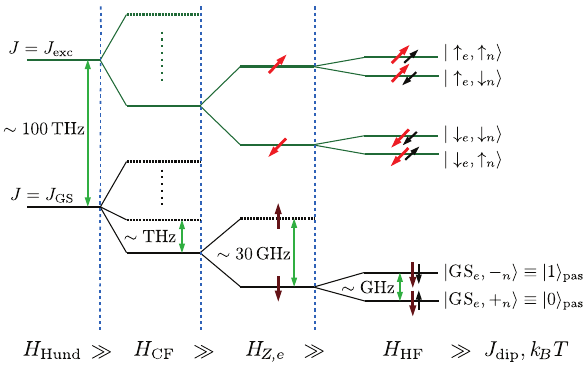
FIG. 2. The optimal level scheme of a Kramers RE ion in a CF field, showing the energy scales governing Hamiltonian (1). We use the ground state and one excited spin-orbit manifold, requir- ing the lowest-lying states of both manifolds to be CF doublets with different anisotropy directions, which we then Zeeman split with an external field. From the ground state doublet we only need the lower Zeeman state. The coupling to a nuclear spin with I = 1 / 2 splits the electronic states into pairs of hyperfine states, where the nuclear spins are either aligned or antialigned with the electronic spin. The spatial density of the RE ions is adjusted such that the dipolar interactions J dip have by far the smallest energy scale (apart from the nuclear Zeeman